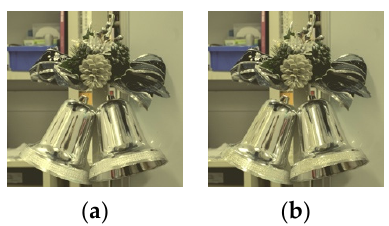
Figure 8. Images with logarithmic function applied (Xperia1). ( a ) threshold: 0.9 parameter: 1.5; ( b ) threshold: 0.9 parameter: 3.5.